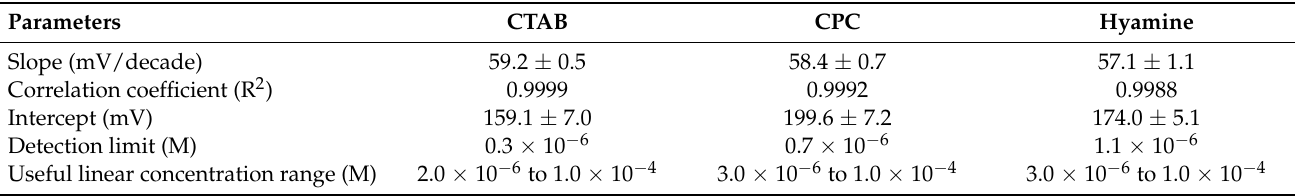
Table 1. Calculated response characteristics for the DHBI–TPB surfactant sensor to CTAB, CPC and Hyamine cationic surfactants with mean values at ± 95% confidence